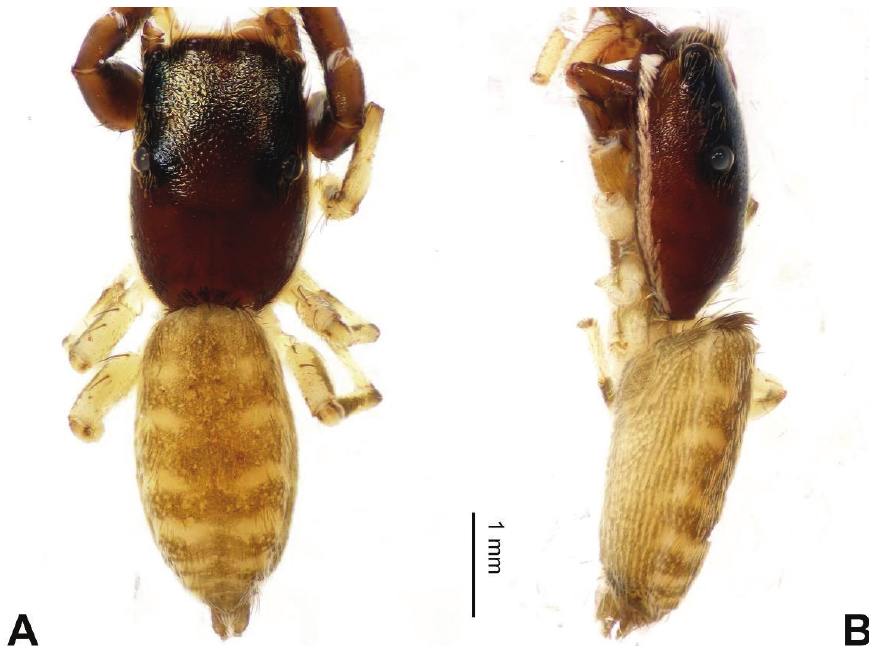
Figure 27. Habitus of Icius bamboo sp. n., male holotype. A dorsal B lateral. Labium brown, tip with greyish hairs. Sternum greyish brown. Abdomen oval, with transverse alternating dark and light stripes. Venter and spinnerets grey. Legs I more robust and darker than other legs, which are yellowish. Spination of leg I: femur d4- 1-1; tibia v2-0-2; metatarsus v2-0-2. Palpal tibia short, about 1/3 the length of cymbi- um, RTA bent, strong and with blunt tip (Fig. 26B). Bulb about twice as long as wide. Seminal duct encircling tegulum retrolaterally. Embolus short, digitiform, (Fig. 26D). Female.